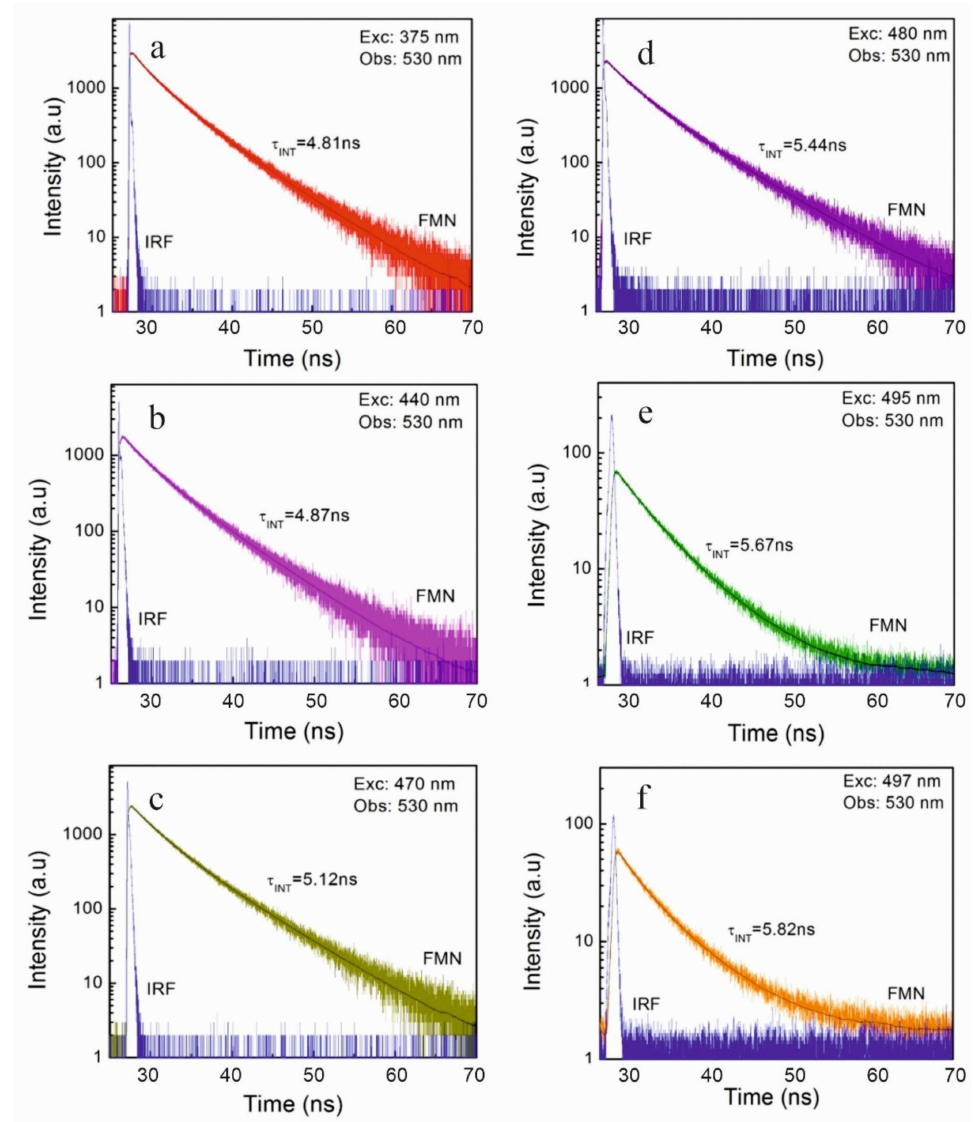
Figure 8. Fluorescence intensity decay of the FMN sample (C = 7 × 10 − 5 M) upon excitations at 375 nm, 440 nm, 470 nm, 480 nm, 495 nm, and 497 nm, originating from the “blue” centers to the “red” centers. Table 5 lists the values of the mean FMN fluorescence lifetimes (cid:104) τ (cid:105)